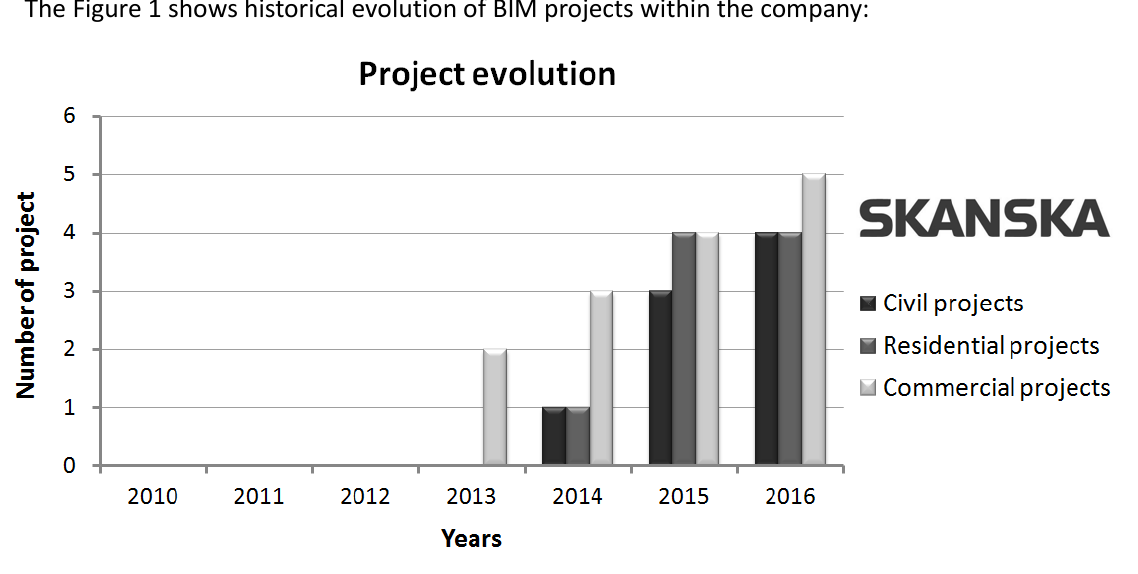
Figure 1: Evolution of BIM projects at Skanska (source: